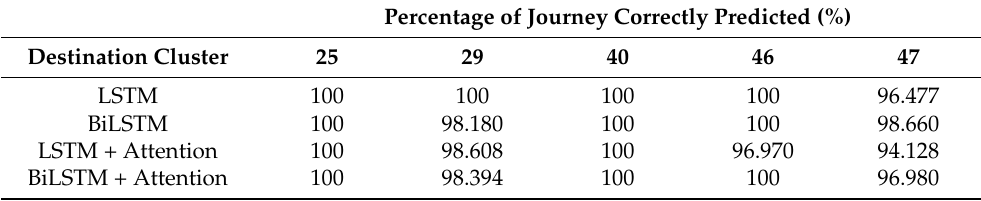
Table 6. Results from testing each model on a frequent destination journey.